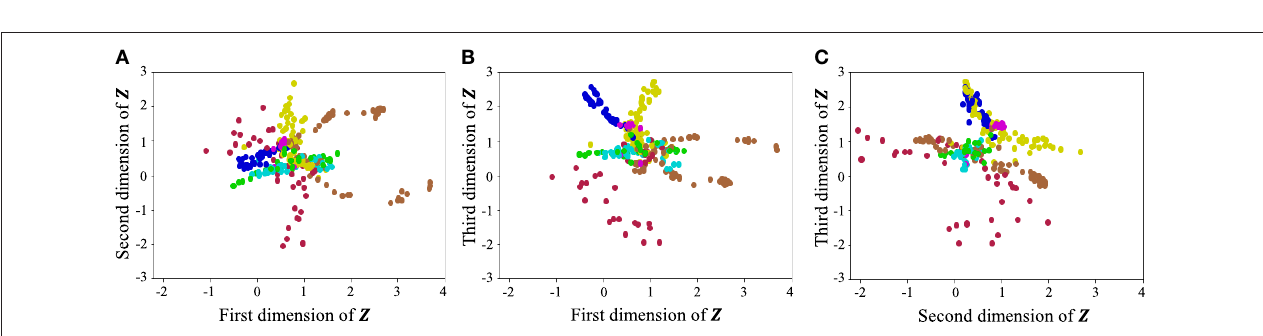
FIGURE 19 | Latent space of the HVGH: (A–C) respectively represent the first and second, first and third, and second and third dimension of the latent variables. The color of each point, which is latent variable reflects the correct motion class.